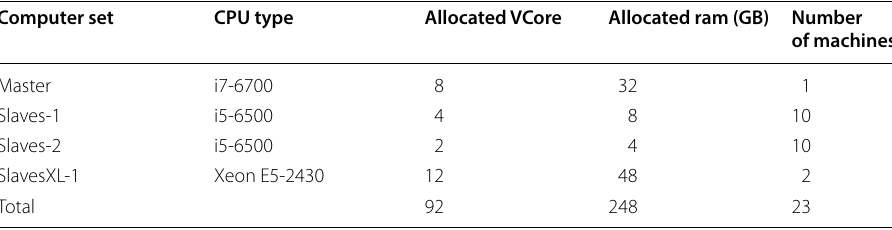
Table 1 Resource specifications for the cluster Computer